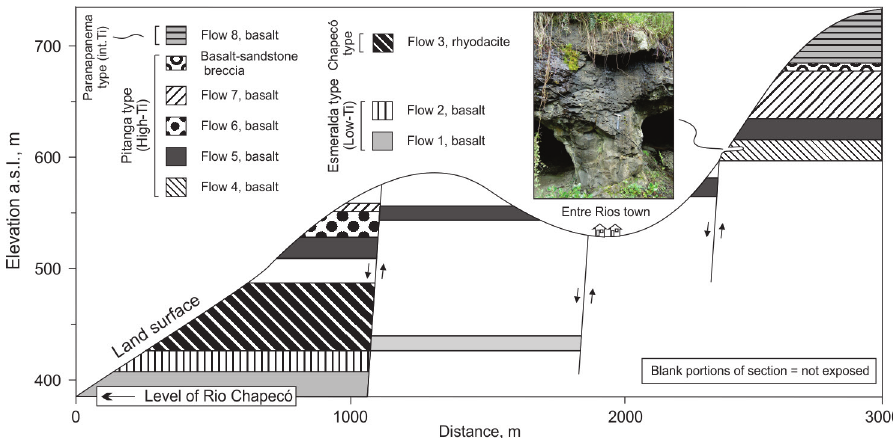
Figure 7 - Geological section of the Entre Rios mining district. Inset photo shows the entrance to underground mine.